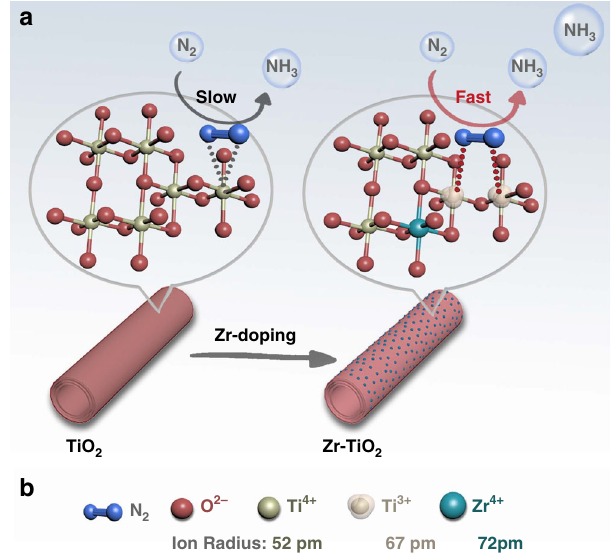
Fig. 1 Schematic illustration of N 2 fi xation and activation. a The formation of an oxygen vacancy (Vo) and adjacent bi-Ti 3 + sites owing to the Zr-doping in anatase TiO 2 . b Comparison of the ionic radius of Ti 4 + , Ti 3 + , and Zr 4